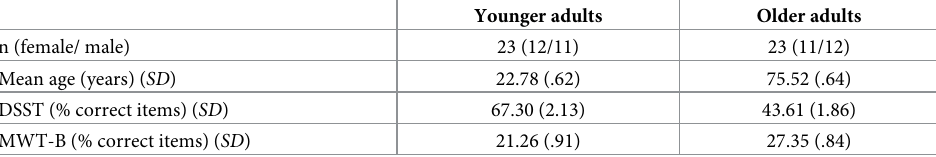
Table 1. Sample overview and results of psychometric tests (means and standard